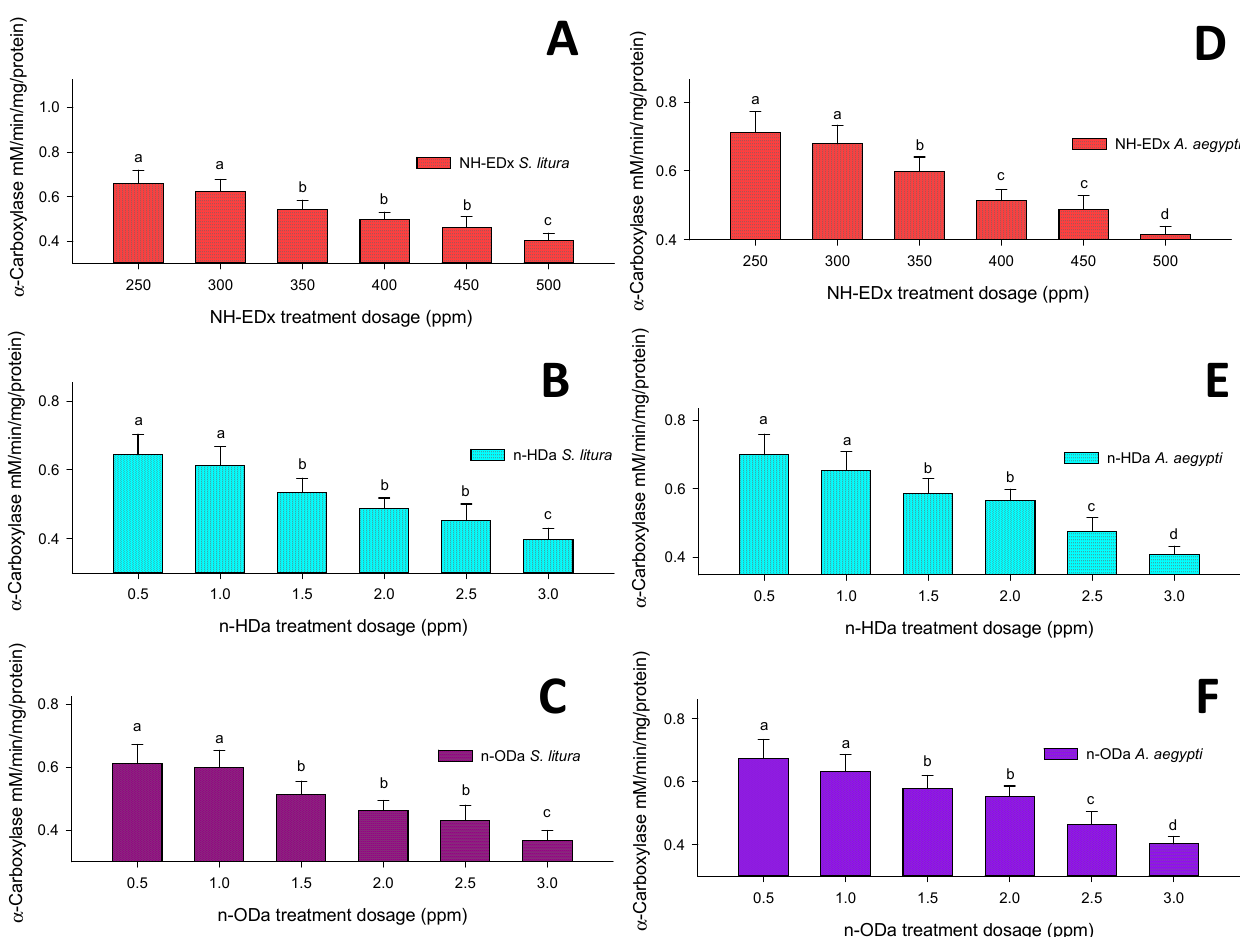
Figure 7. α -carboxylesterase enzyme activity of the fourth instars of S. litura after treatment with ( A ) NH-EDx, ( B ) n -HDa, and ( C ) n -ODa, and of fourth instars of A. aegypti after treatment with ( D ) NH-EDx, ( E ) n -HDa, and ( F ) n -ODa, respectively. The data were fitted on a polynomial (regression) model. Vertical bars followed by letters indicate standard error (±SEM).